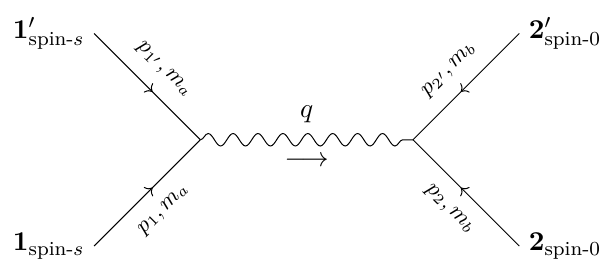
Figure 5 . A probe scalar particle interacting with a non-BPS spinning particle. For particle 1 , the central charges are ( Z ) , while for particle 2 , the central charges are ( Z a 12 , Z a 34